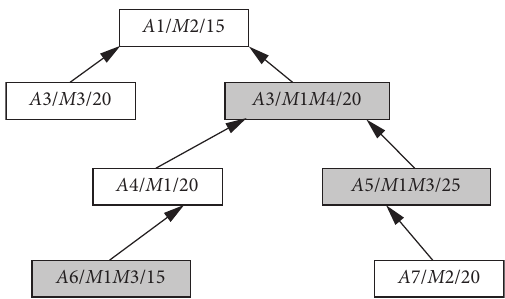
Figure 1: A product process tree with